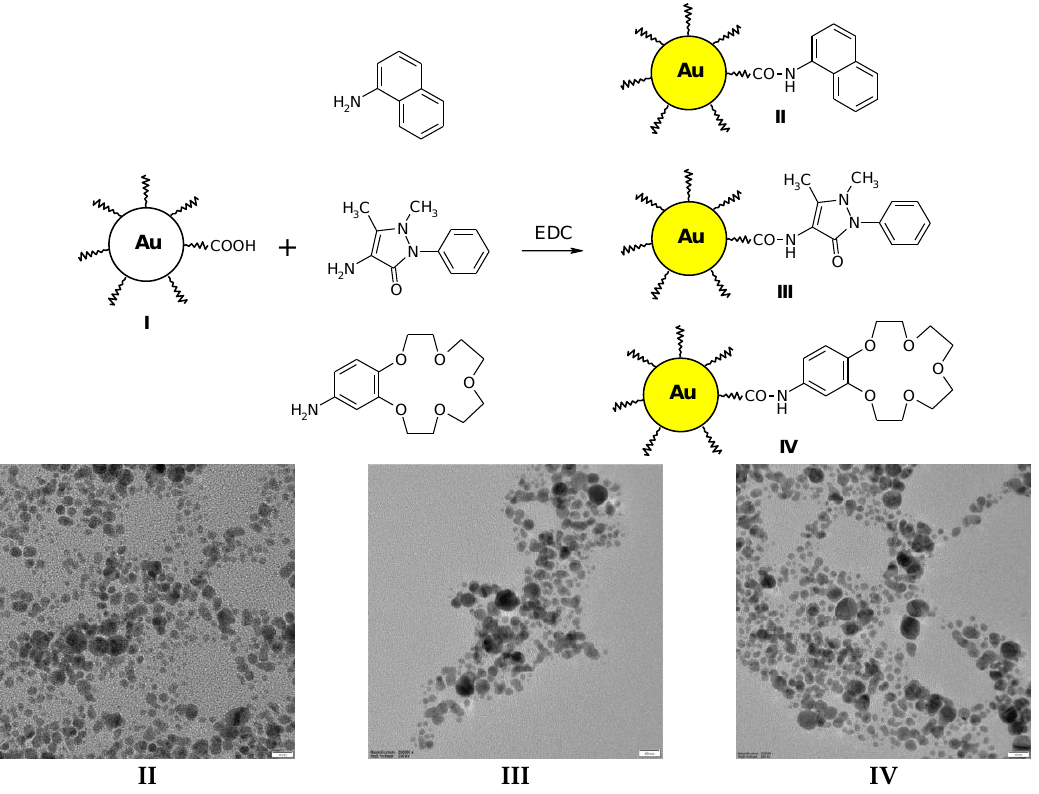
Figure 2. Top: Functionalization of Au NPs ( I ) with 1-naphtylamine, 4-aminoantipyrine, and 4′-amino-benzo-crown-5, yielding samples II – IV ; Bottom: TEM images of samples II , III , and IV , respectively (scale bar 10 nm).